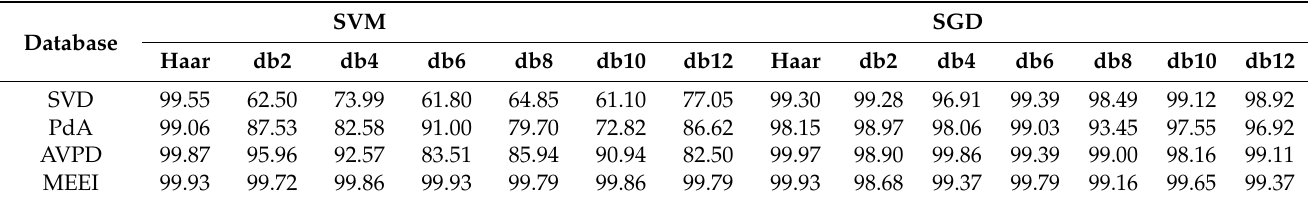
Table 18. Voice dysfunction detection accuracy (%) using Haar and Daubechies.